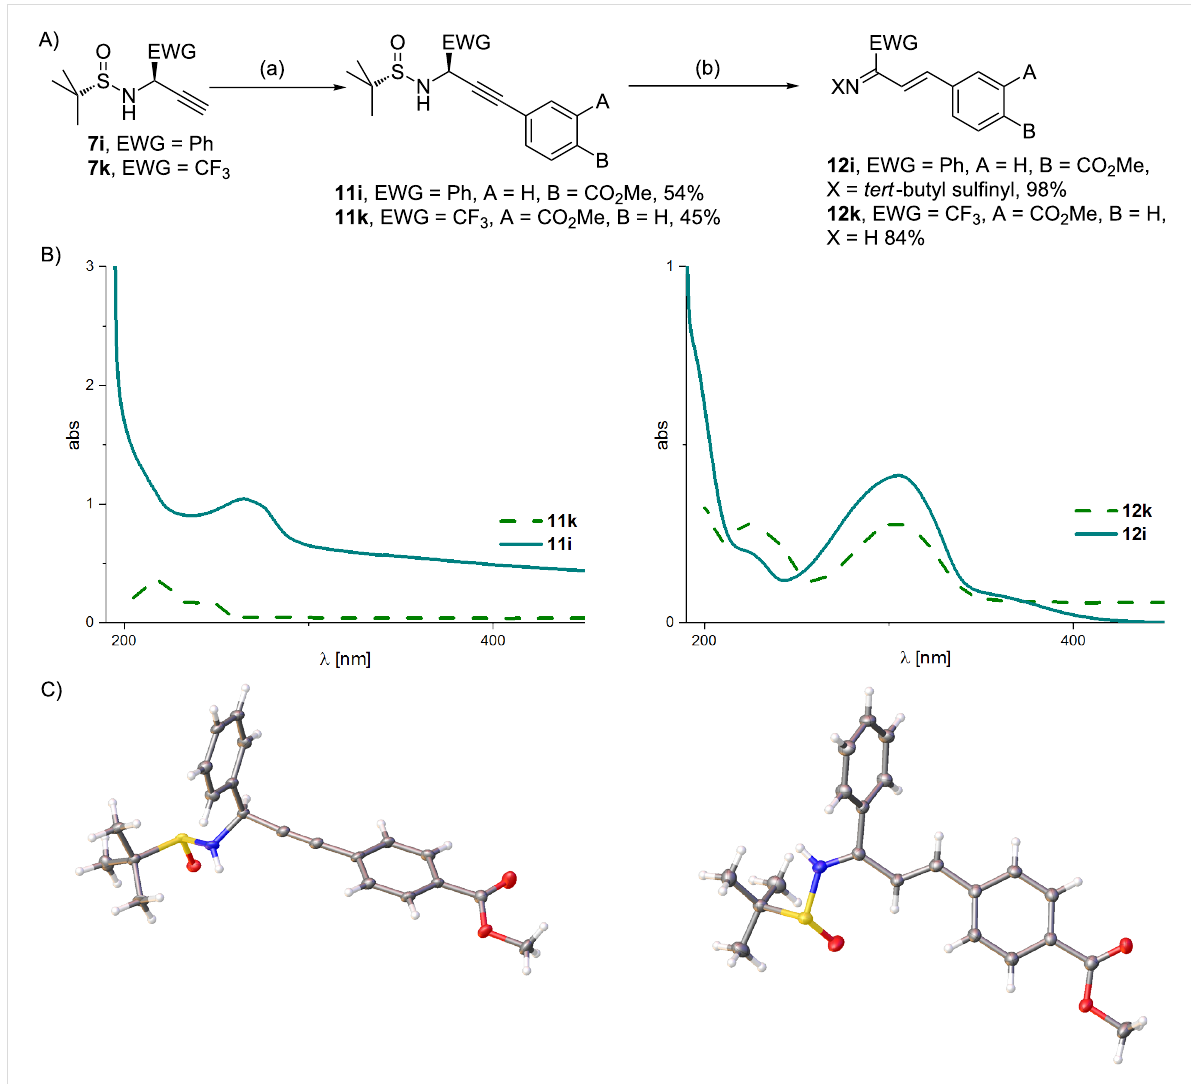
Figure 9: Base-catalyzed rearrangement of propargylamines 11 to α , β -unsaturated imines 12 . A) Reaction scheme: (a) methyl 4-iodobenzoate (for the conversion of 7i to 11i , 1.6 equiv) or methyl 3-iodobenzoate (for the conversion of 7k to 11k ), DIPEA (6 equiv), THF, Cl 2 Pd(PPh 3 ) 2 , CuI, room temperature, 2 h (GP-9). (b) Piperidine/THF (1:3), 0 °C, 30 min (conversion of 11i to 12i ). Or LiOH (3 equiv), MeOH/H 2 O (2:1), 0 °C, 30 min. B) UV–vis spectra of propargylamines 11 and α , β -unsaturated imines 12 . C) X-ray crystal structure analysis of propargylamine 11i and α , β -unsatu- rated imine 12i